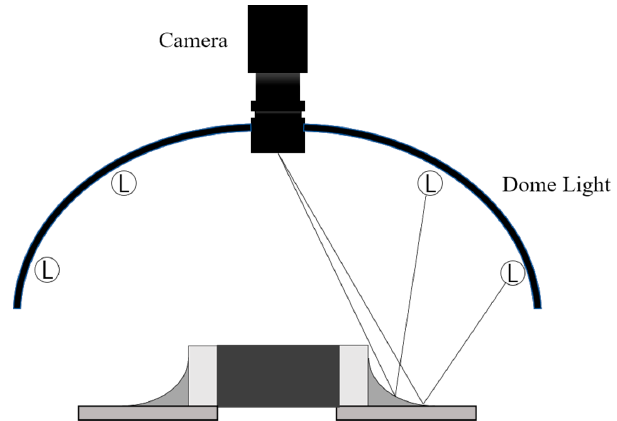
Figure 3. Red, green and blue (RGB) light system using light-emitting diode (LED) lights.